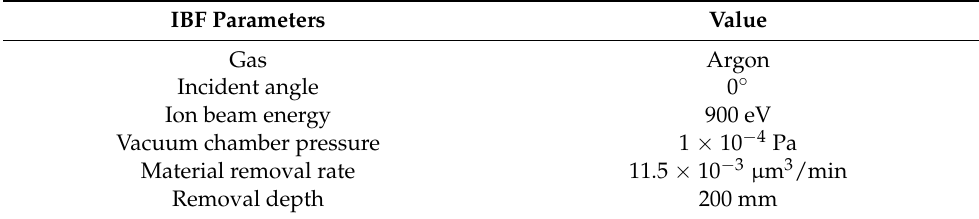
Table 3. Ion beam finishing (IBF) technique parameters of sample